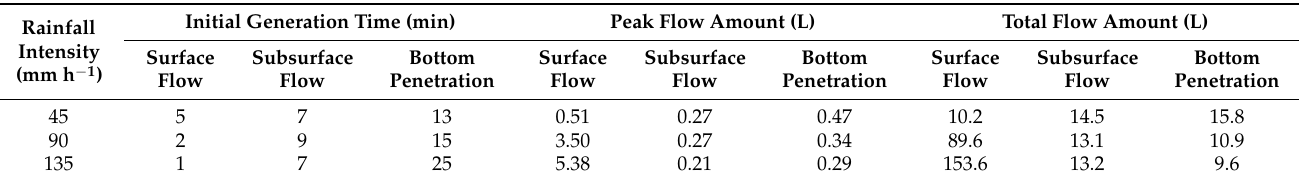
Figure 3. The surface flow generation processes under different rainfall intensities. The dotted lines indicate the mean surface flow coefficients. Error bars represent standard errors of the means ( n = 30). Bars with different letters differ significantly. Table 2. The hydrological characteristics of the rainfall – flow under different intensities.